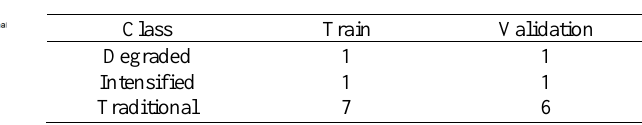
Table 2. Number of location assigned for train and validation Figure 2. Example of original (black line) and smoothed NDVI The algorithm evaluates the locations designated for time series using Savitzky-Golay filter (red line) of one field with pasture intensification.